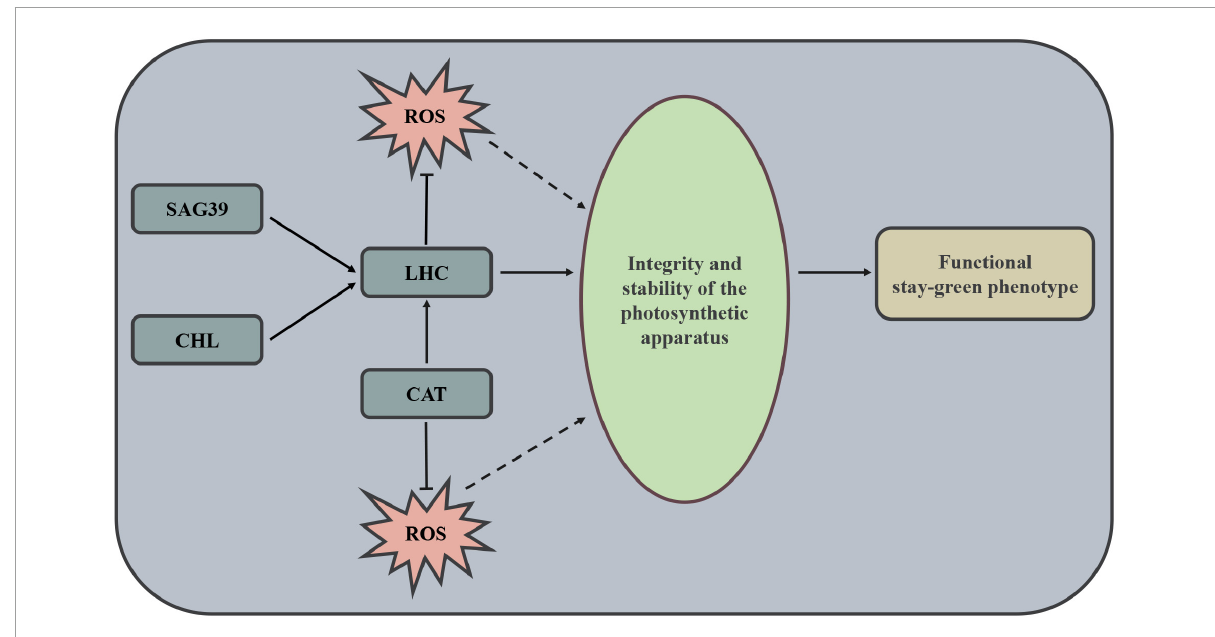
FIGURE6 Mechanism governing the functional stay-green phenotype of wheat cultivar CN17. SAG, senescence-associated gene; CHL, chlorophyll; LHC, light-harvesting chlorophyll protein complex; CAT, Catalase; ROS, Reactive oxygen